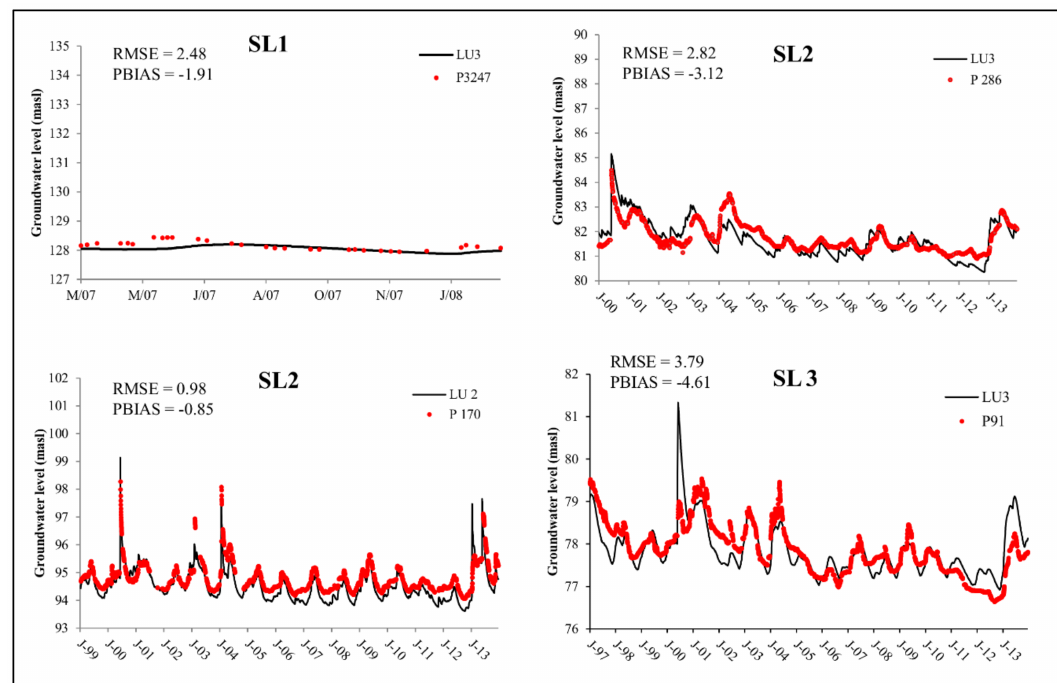
Figure 3. Simulated and observed groundwater levels in the three subbasin-LUs. The grey lines are the simulated series considering the water connection with the upland area. The black lines are the simulated results without the water connection (the model efficiency criteria values are the performances of black lines). RMSE = root means square error and PBIAS = percent bias.